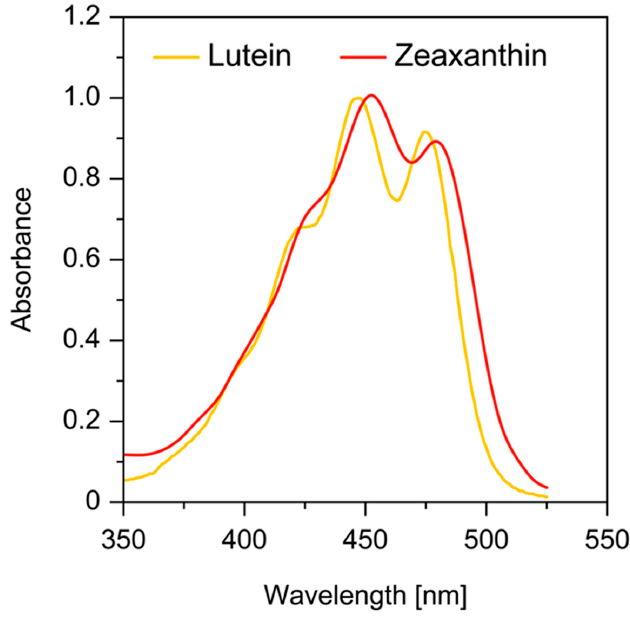
Figure 2. Absorption spectra of zeaxanthin and lutein in ethanol.